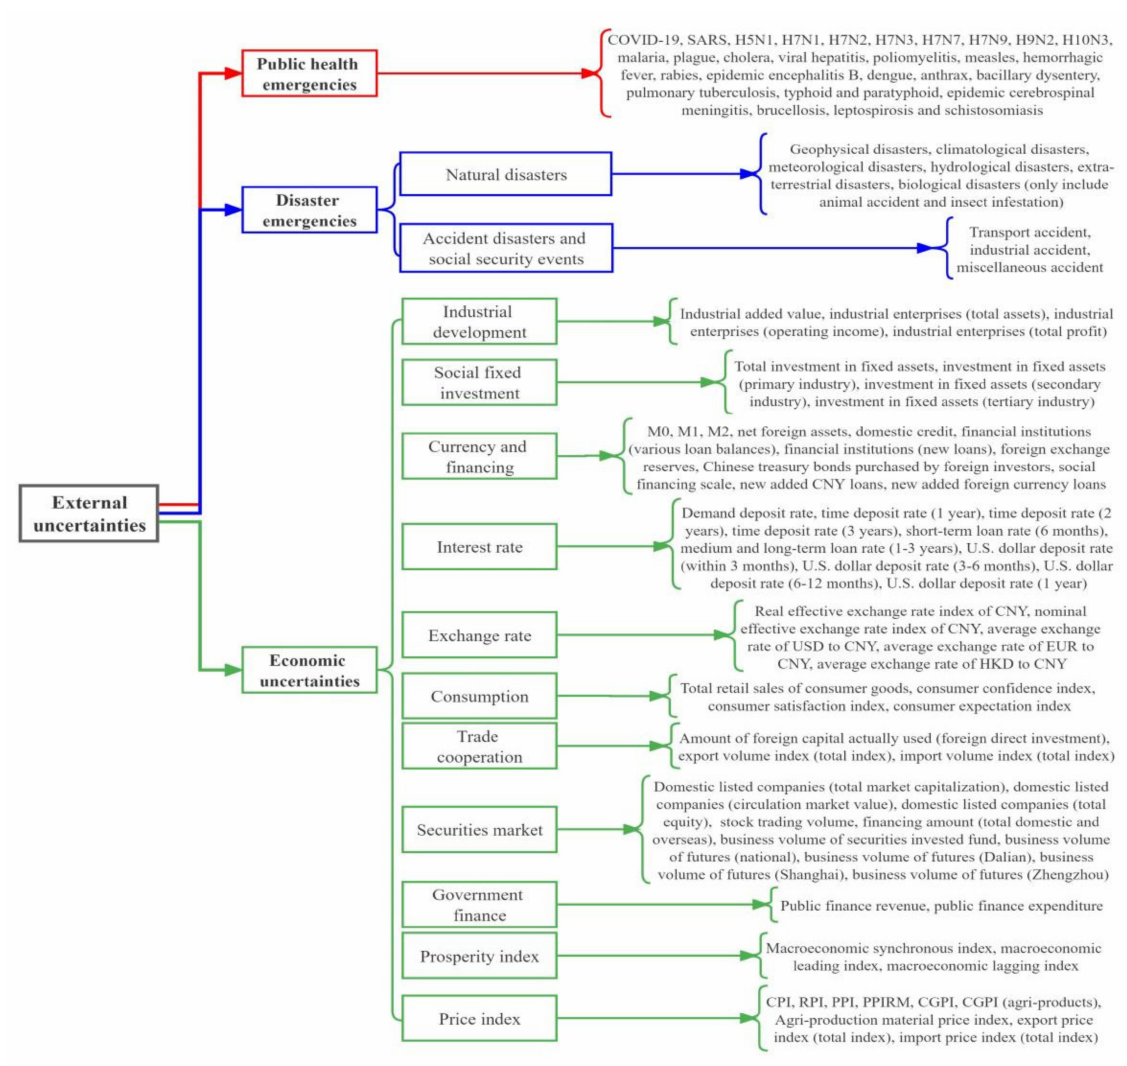
Figure 2. Sources and classification of external